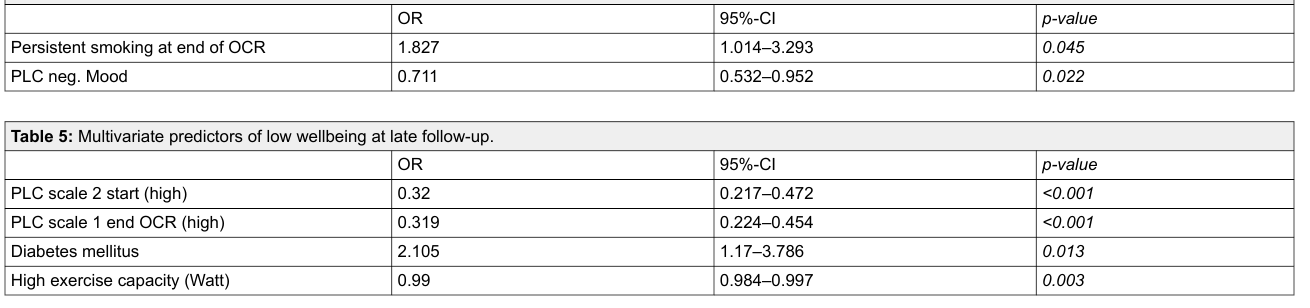
Table 4: Multivariate analysis of predictors of depressive symptoms at late follow-up.